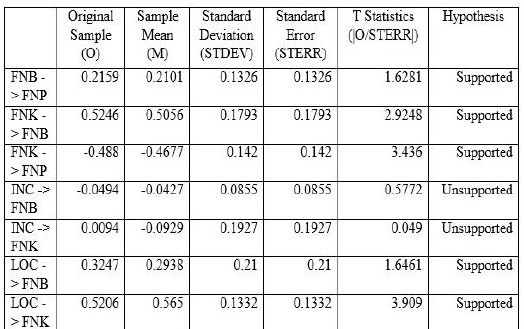
Table 7: The t-values of the Hypothetical Model